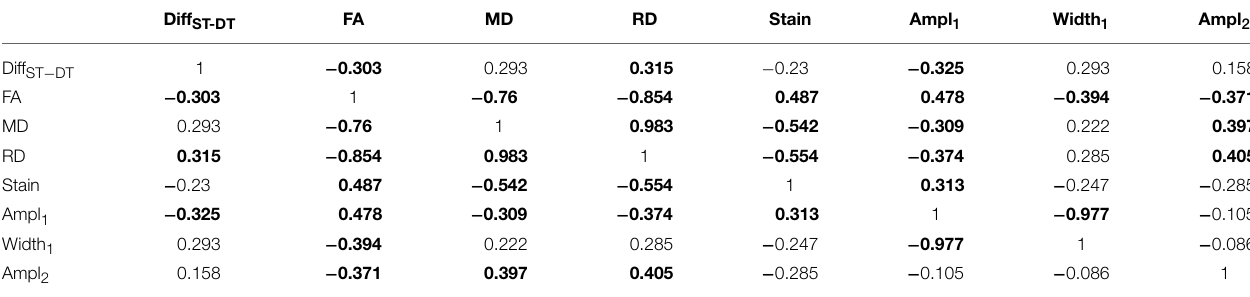
TABLE 1 | Correlation table of histological and dMRI features. Diff ST-DT FA MD RD Stain Ampl 1 Width